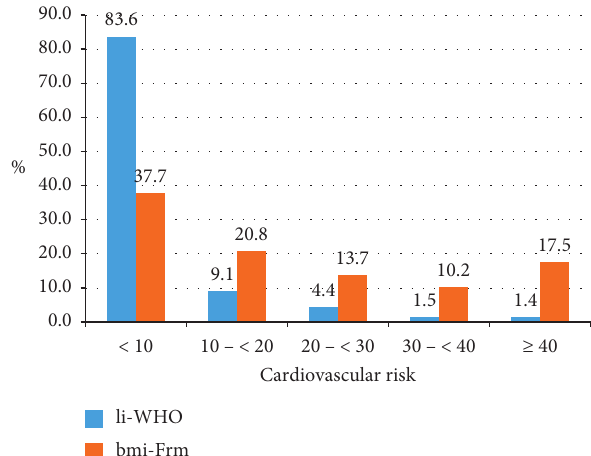
Figure 1: Body mass index-based Framingham and low-information WHO-based cardiovascular risk scores in the sample of 793 patients.